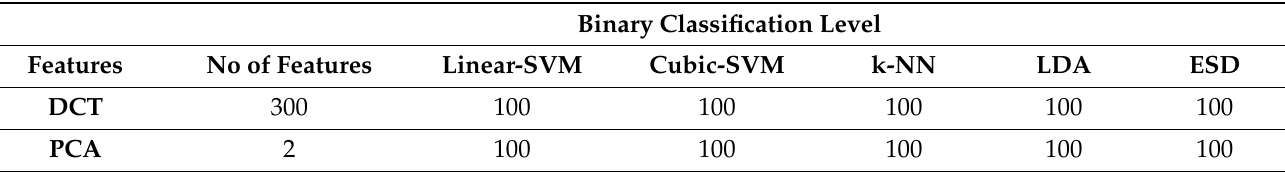
Table 9. The numbers of discrete cosine transform (DCT) and principal components, and classification testing accuracy (%) for the five classifiers used in MB-AI-His after the fusion using PCA and DCT for the binary classification level.